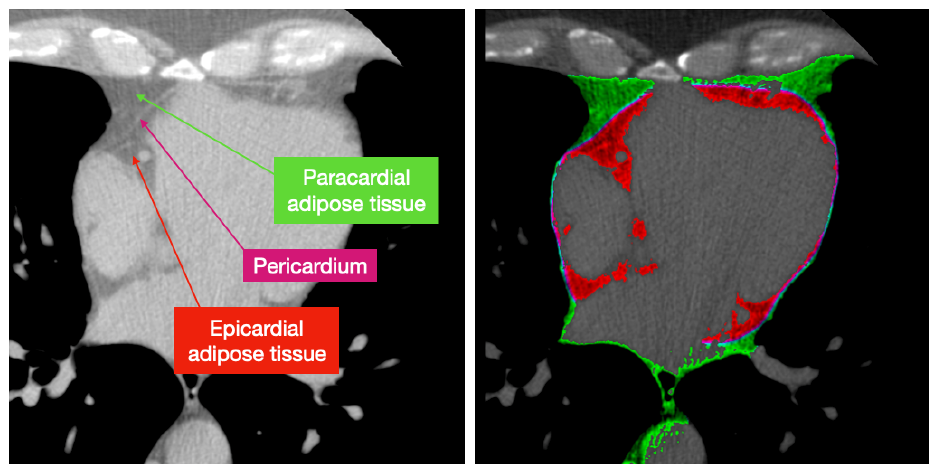
Figure 3. The anatomy of the pericardium, EAT and paracardial adipose tissue on a CT scan [20]. Epicardial adipose tissue is most loosely defined as any adipose tissue within the pericardial sac. The fat immediately outside the pericardial sac is called paracardial fat, and together they form pericardial fat [6,21]. Epicardial fat is mostly concentrated in the atrioventricular and interventricular grooves and along the major branches of the coronary arteries and around the atria Sacks and Fain [10]. Paracardial fat is concentrated on the outside of the parietal pericardium within the